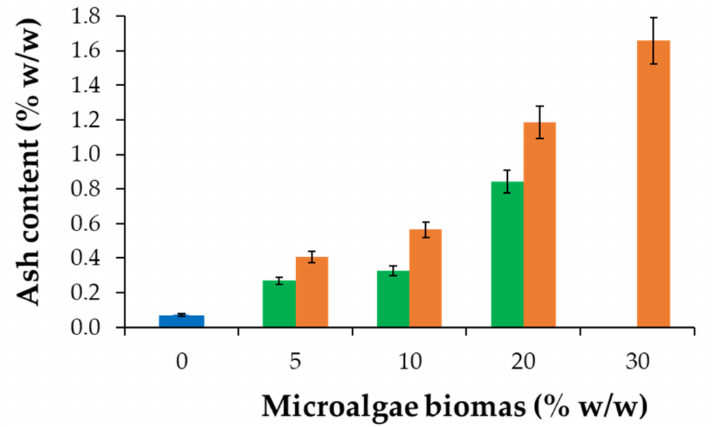
Figure 7. Ash content of MSBS with different content of microalgae: Chlorella (green bar), and Spirulina (orange bar), and in control sample–copolymer matrix (blue